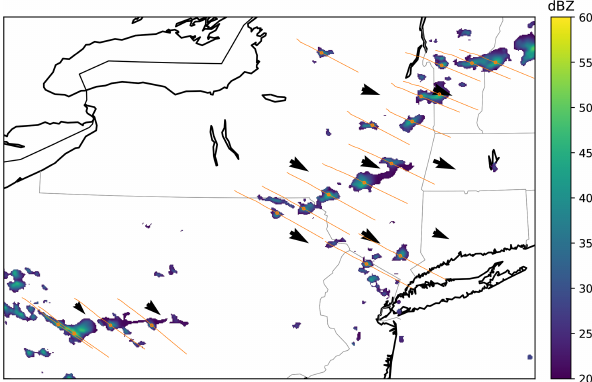
Figure 2. An example of the extracted centers at time t = 0 (orange circles) and tracks from t − 60 to t + 60min (orange lines). MAXZ in dBZ is shown in the colored map, with coastlines and state borders shown in the